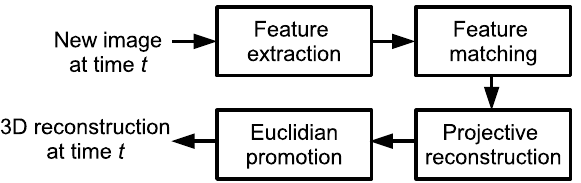
Figure 2: Reconstruction procedure